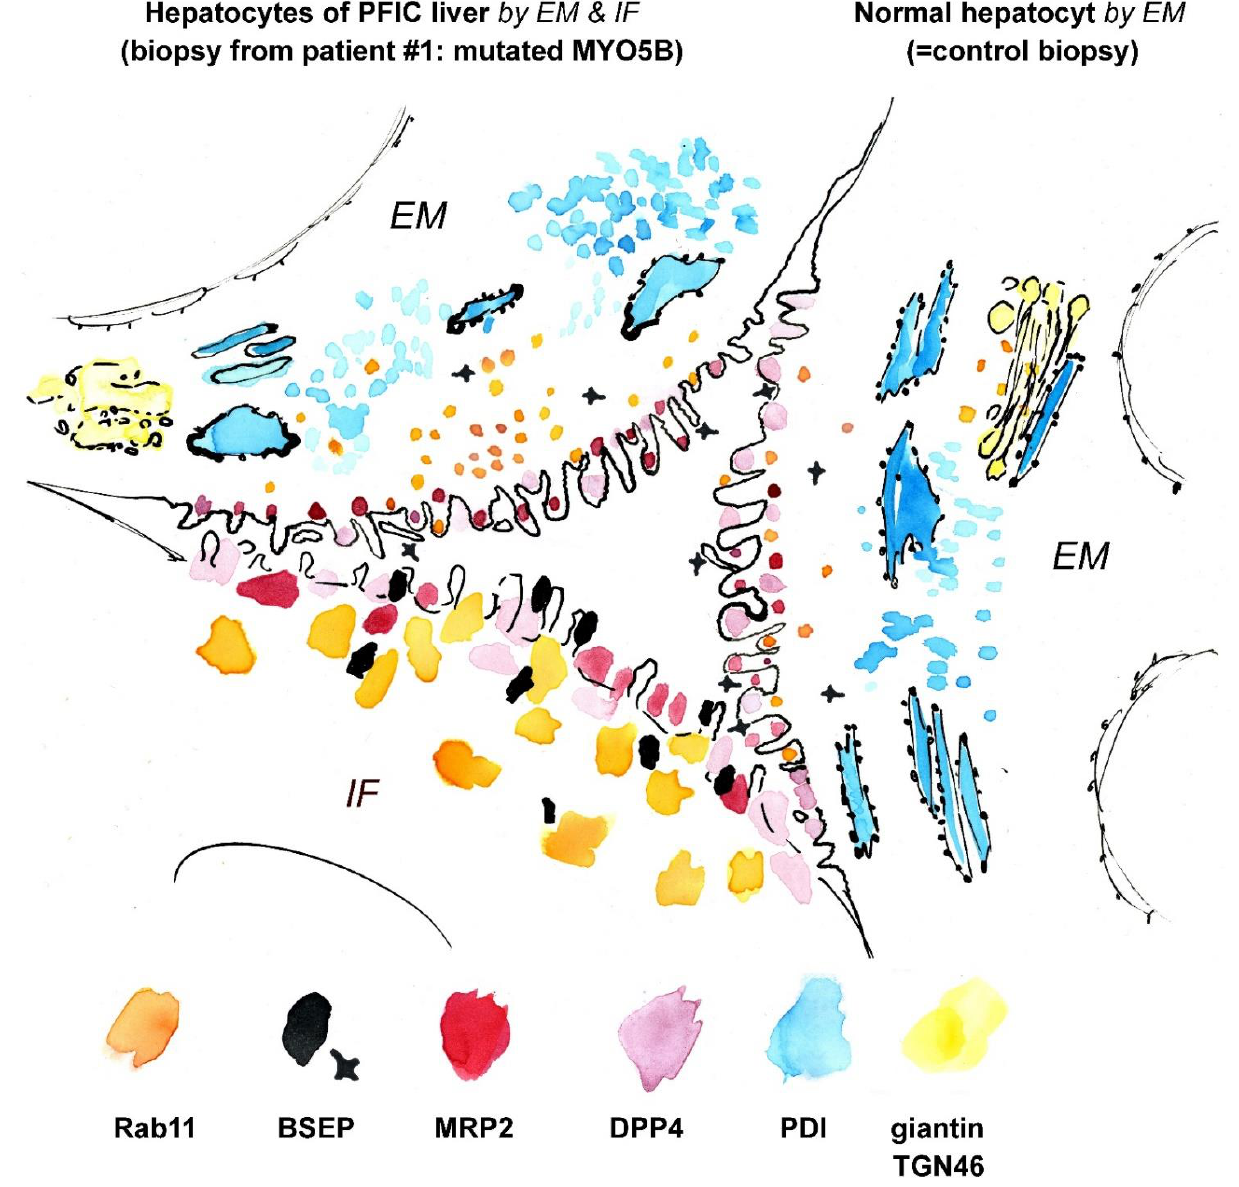
Figure 11. Synoptic view on a virtual (“compound”) bile canaliculus. The illustration compares the immuno-labeling patterns of cholestatic hepatocytes from patient #1 (with mutated MYO5B; shown on the left) with those of normal hepatocytes (shown on the right). Immuno-EM (EM) provided more detailed information in terms of structure and the precision of marker localization than immuno-fluorescence (IF). Partly mislocalized Rab11 and BSEP label is seen in cholestatic hepatocytes, whereas DPP4 and MRP2 are located normally. Drawing roughly to scale. See also Supplementary Material Table S1.